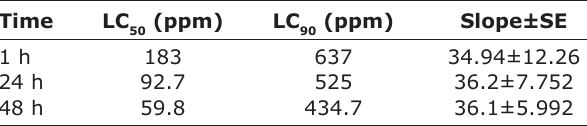
Table-2: LC and LC values of Aedes aegypti mosquito 50 90 larvae using essential oil Piper betle